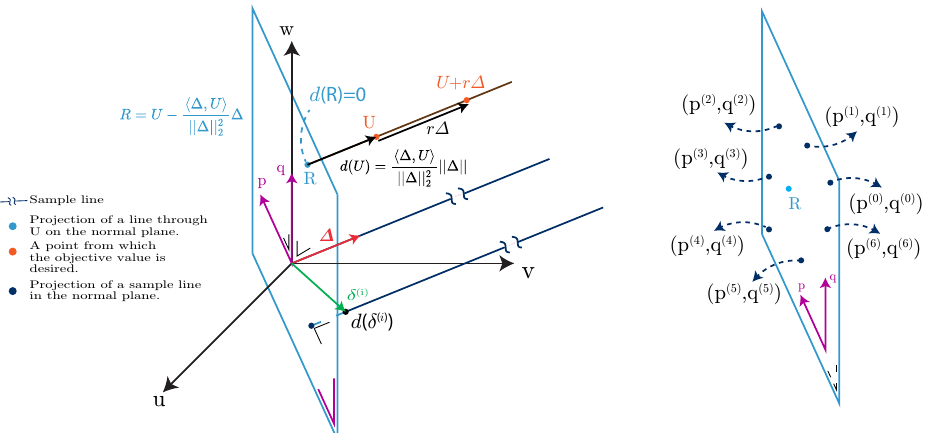
Figure 14. The intersection point R of the line U + r ∆ , parallel with ∆ and through U , at the left. All l = 7 lines’ intersection points ( p ( i ) , q ( i ) ) with the normal plane at the